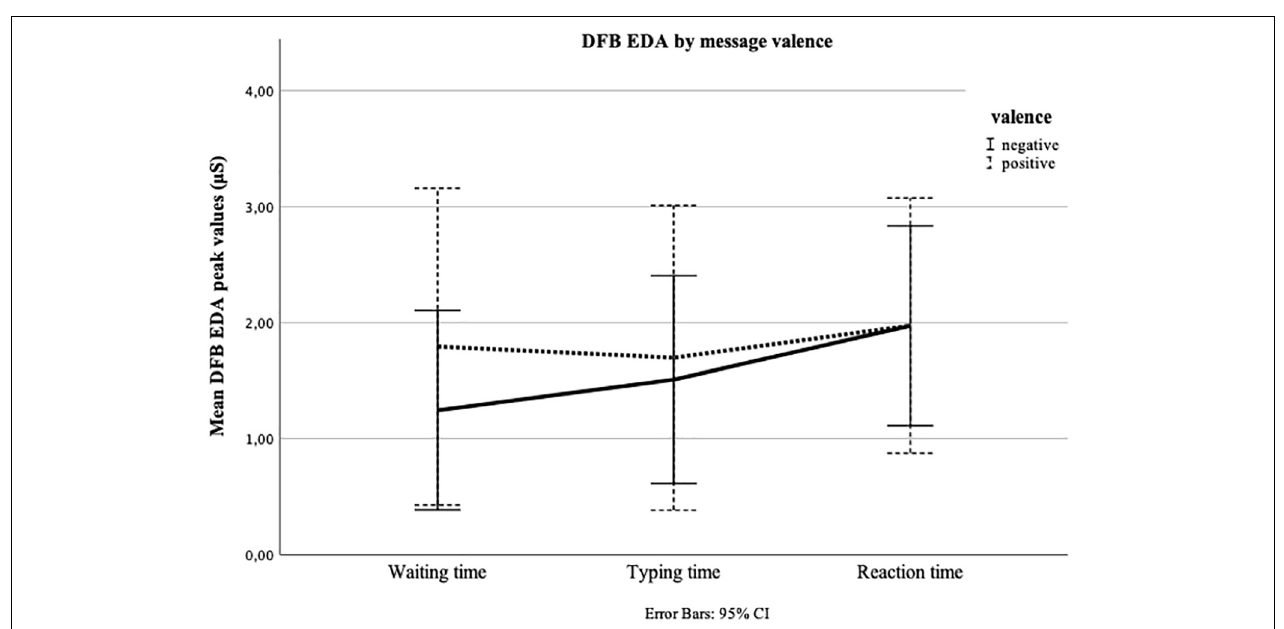
FIGURE 6 | Repeated measures of electrodermal activity (EDA) in microSiemens ( µ S) for Waiting time, Typing time, and Reaction time by message valence (positive = positive answer from peer; negative = negative answer from peer). The y -axis shows the mean peak value calculated as a deviation from the baseline measure (DFB) for the final 30 s of Waiting time, the first 30 s of Typing time, and the first 30 s of Reaction time.